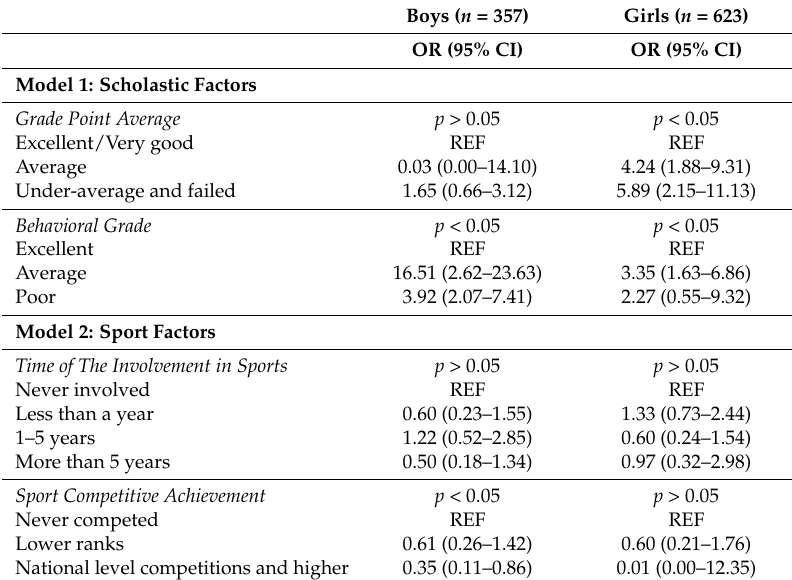
Table 1. Logistic regression models for daily smoking in boys and